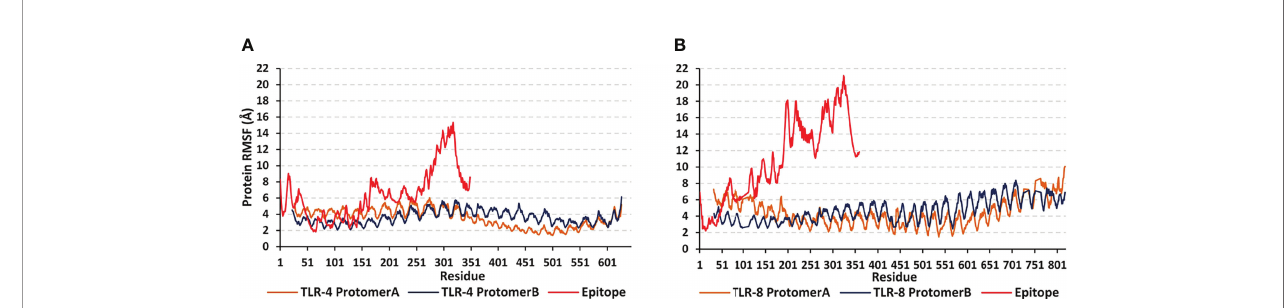
FIGURE 7 | Global stability analysis and residue-wise mobility trends of the simulated multiepitope vaccine in complex with different TLRs along 100 ns all-atom simulation runs. The protein ’ s C a RMSFs (Å) of simulated (A) epitope/TLR-4 model; (B) epitope/TLR-8 model, were represented as a function of constituting residue sequence